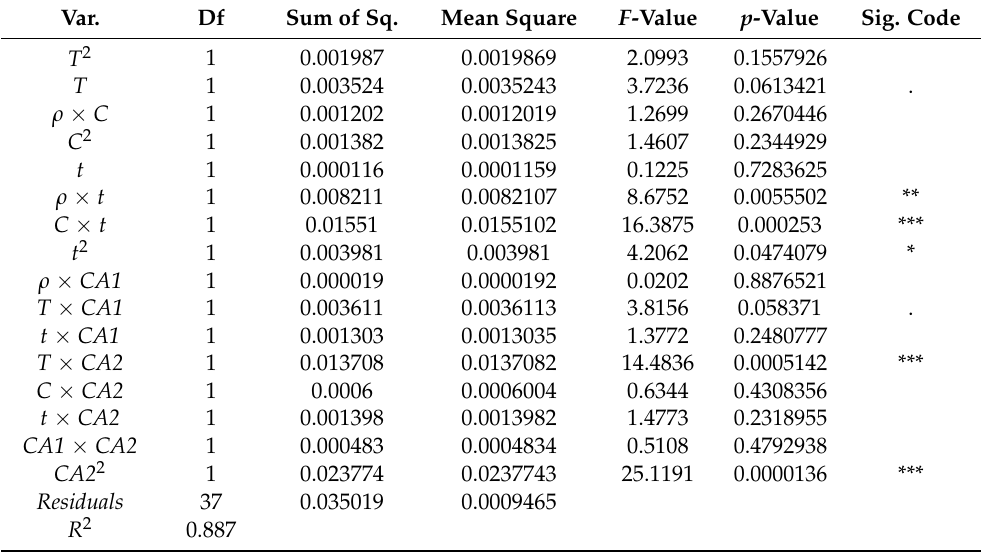
Table 6. ANOVA table for the “ R ” quadratic model. Var.